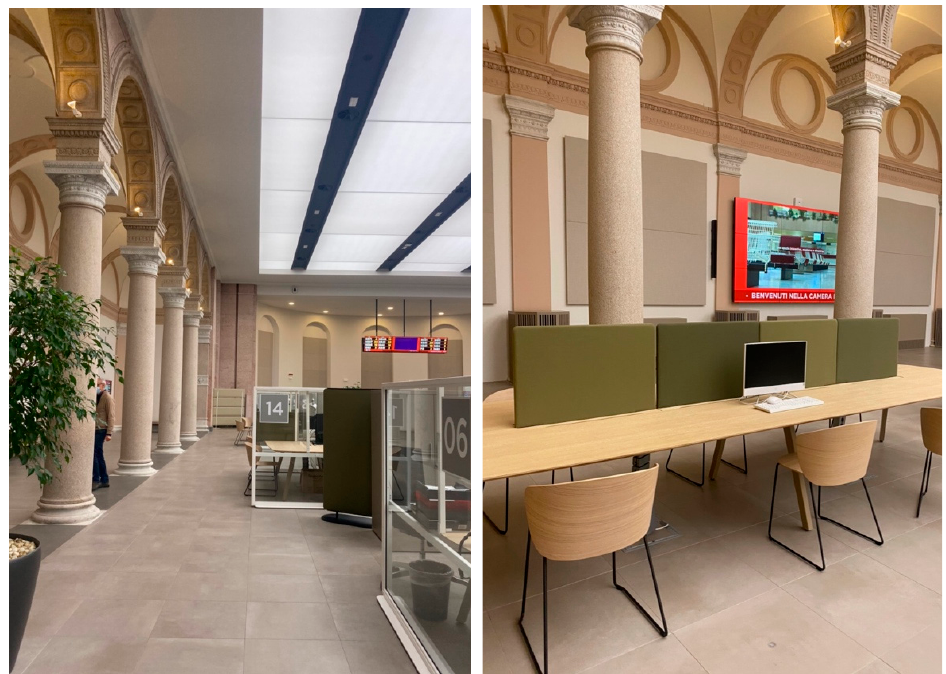
Figure 7. Pictures of the realised Hall of the Future spaces.